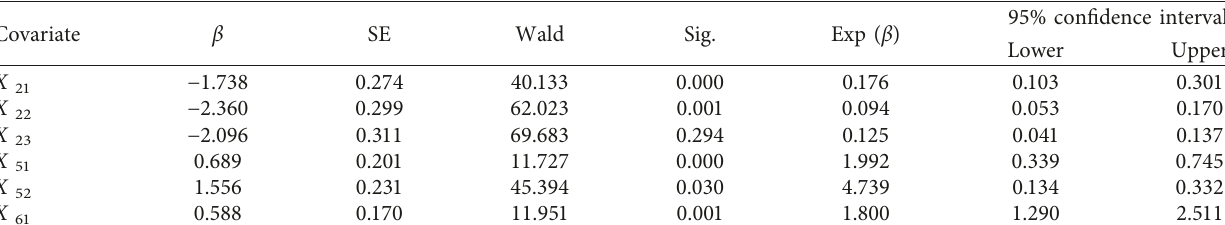
Figure 10: Distribution characteristics of MLCD under traffic conditions. (a) Cumulative survival function curve of road service level. (b)Cumulative hazard function curve of road service level. (c) Cumulative survival function curve of setting exit advance guide signs. (d)Cumulative hazard function curve of setting exit advance guide Table 5: Estimation results of Cox model parameters.